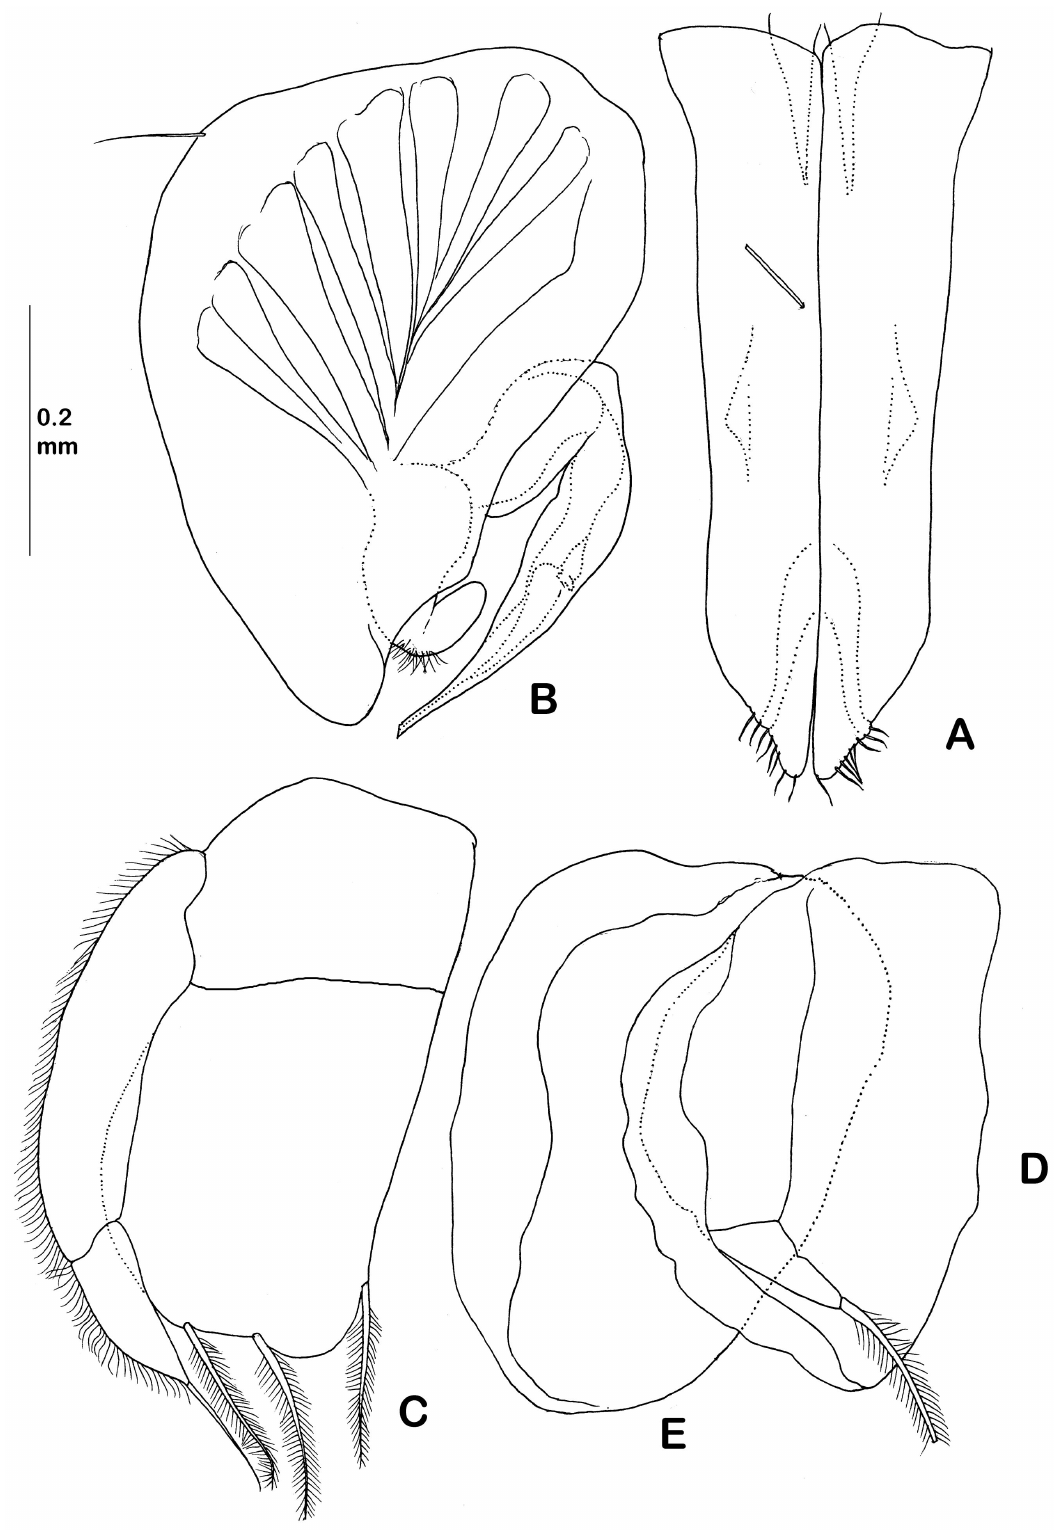
Figure 32. Eurycope jakobi sp. nov. Male holotype (ZMH K-45656): ( A ) pleopod I; ( B ) pleopod II; ( C ) pleopod III; ( D ) pleopod IV; ( E ) pleopod